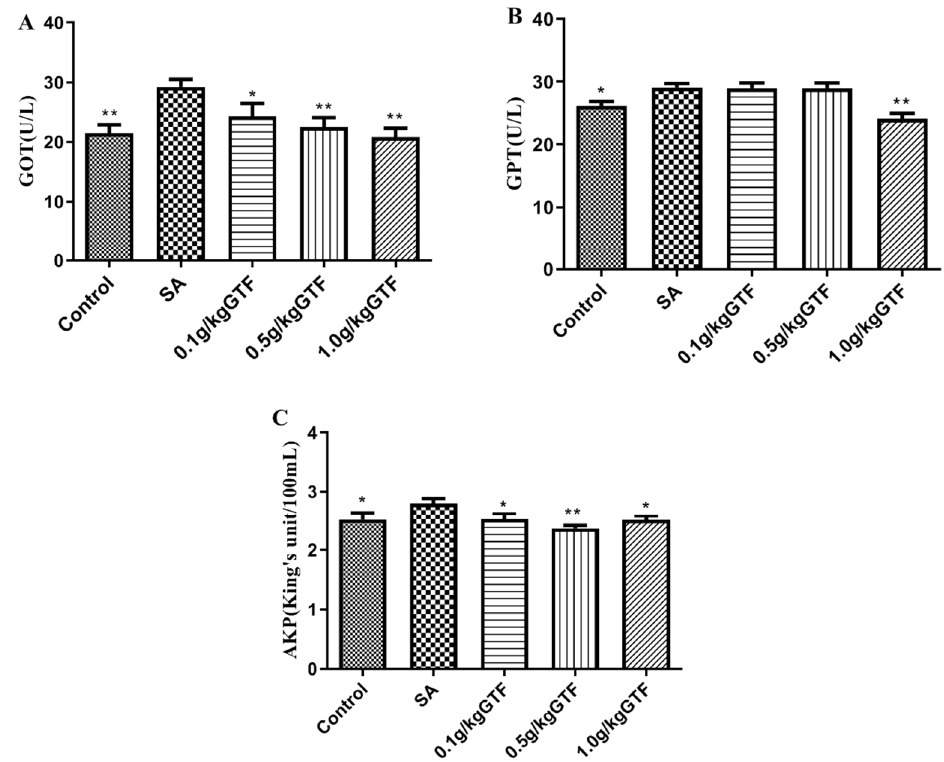
Figure 2. Effects of GTF on GOT ( A ), GPT ( B ) and AKP ( C ) activities in the serum of tilapia. Values are expressed as the mean ± SEM ( n = 10). * p < 0.05; ** p < 0.01, compared with the control group.